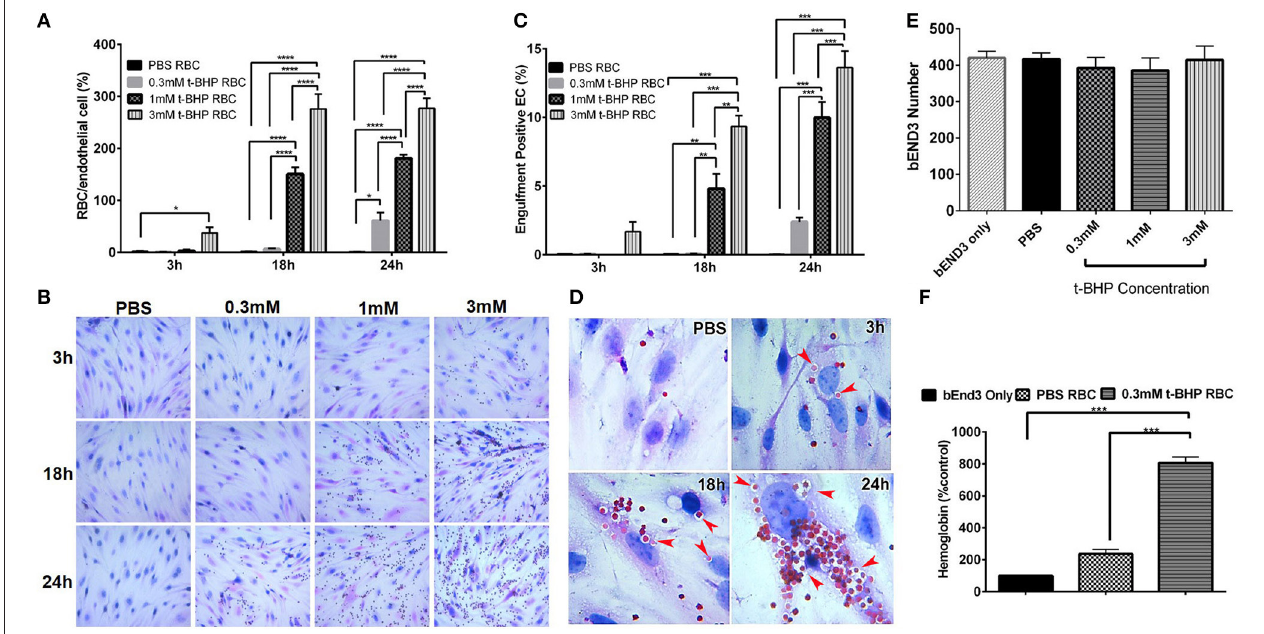
FIGURE 2 | Erythrophagocytosis by brain endothelial cells. Significant time- and concentration-dependent increase in adhesion (A,B) and engulfment (C) of t-BHP-treated RBC compared with PBS-treated RBC using light microscopy. Marked time dependent increase in engulfment of t-BHP-treated RBC by bEND3 cells indicated by red arrows (D) . Brain endothelial erythrophagocytosis at 24h was not associated with bEND3 degradation or loss (E) . Significant increase in the amount of hemoglobin retained by the bEND3 cells incubated with t-BHP-treated RBC compared with PBS-treated RBC following 24h incubation confirming erythrophagocytosis using the DAF colorimetric method (F) . Data is presented as mean ± SEM of at least 3 independent experiments. * p < 0.05, ** p < 0.01, *** p < 0.001, **** p < 0.0001. EC, endothelial